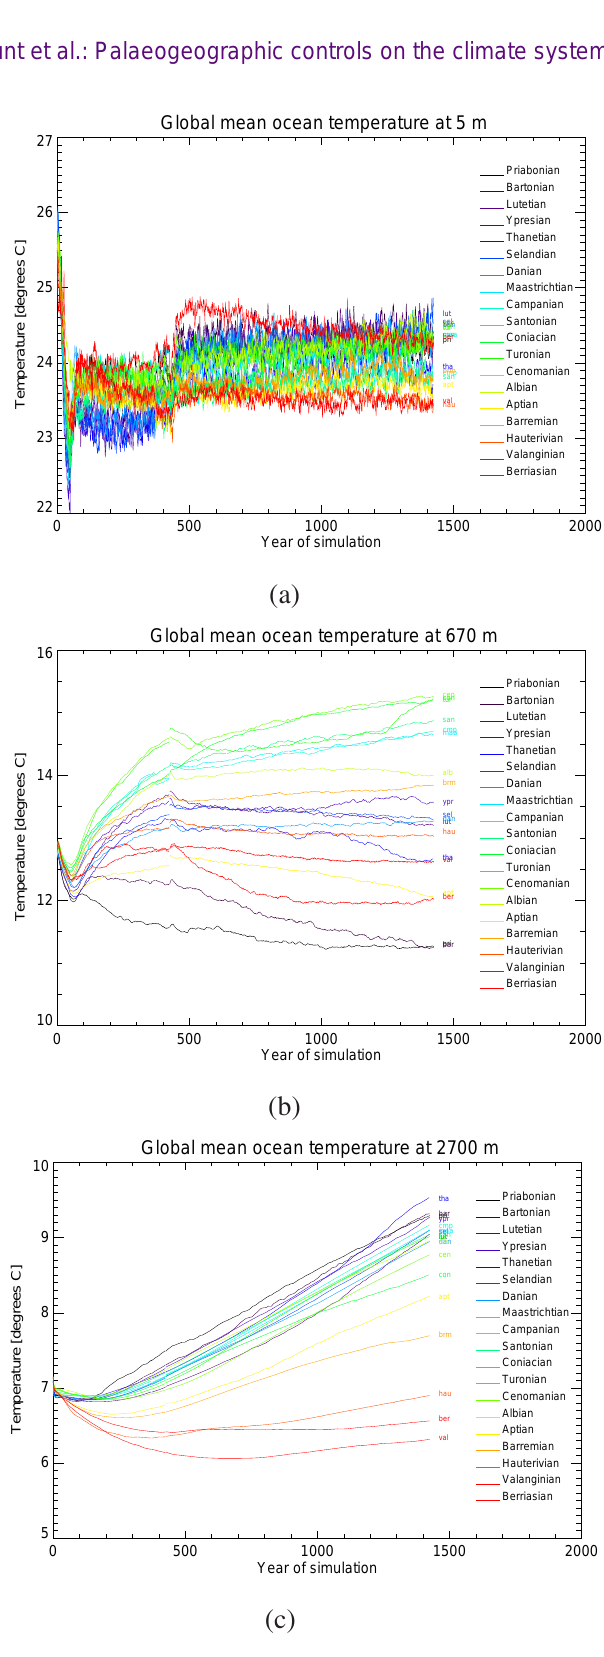
Figure 4. Modelled evolution of global mean ocean temperature [ ◦ C] in each CPE simulation at three depths: (a) surface